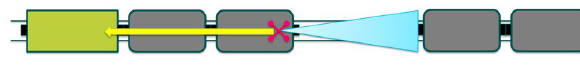
Fig. 7. Sending the signal to the locomotve cabin.